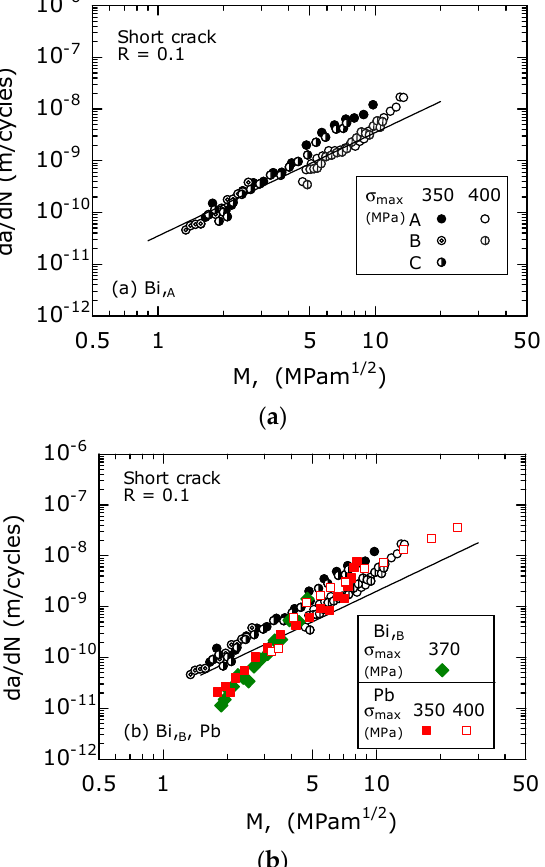
Figure 12. The relationship between d a /d N and M . ( a ) For the Bi, A . ( b ) For the Bi, B , and Pb. The slope of the d a /d N − M relationship for Bi, B , and Pb materials was larger than the slope of two of the straight lines shown in the figure. The reason for this seems to be that with the calculation of M , the same parameter values were used for the three free-cutting brasses. The FCG lifetime N p was obtained by integrating d N from N i to N f , as shown in Equation (11). Here, N i was the crack-initiation life. Furthermore, the integral for d N was converted into the integral for d a from the initial half-length from r e to a f using the FCG rule of Equations (9) and (10), respectively. Here, a f was the half-length of the crack when the specimen broke, and a f = 2 mm (total length of 4 mm) was set in this study, where N f was the sum of N i and N p ( N f = N i + N p ). As shown in Figures 7 and 8, fatigue cracks occurred early in the fatigue process ( N i / N f = 5%); therefore, N i was negligible and was ∼ = N approximated as N f p as shown in Equation (11).